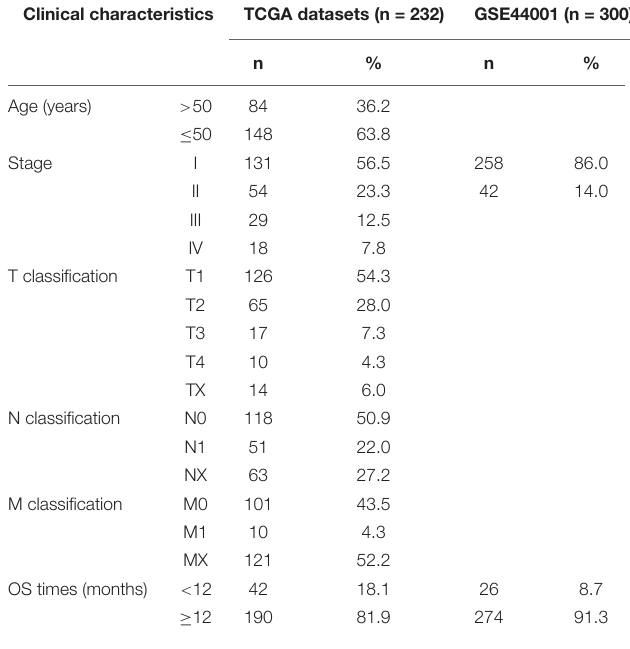
TABLE 1 | Clinicopathological characteristics of patients with cervical cancer (CC). Clinical